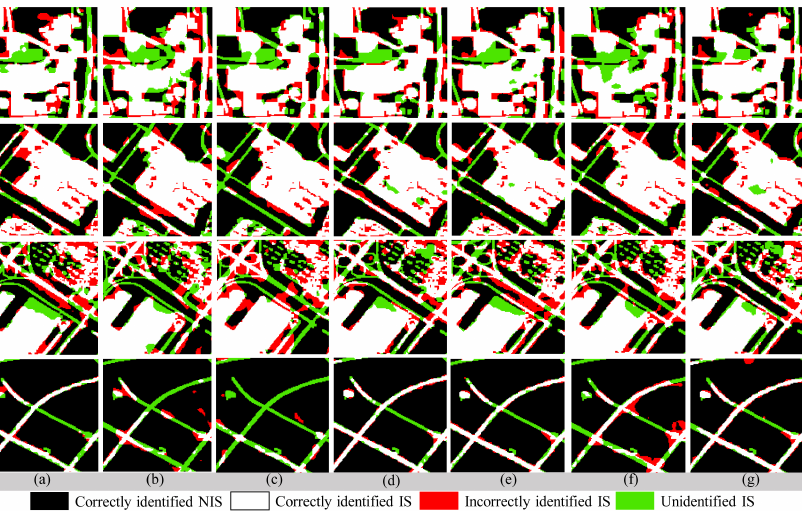
Figure 10. Impervious surface extraction results based on Deeplabv3+ with various features.